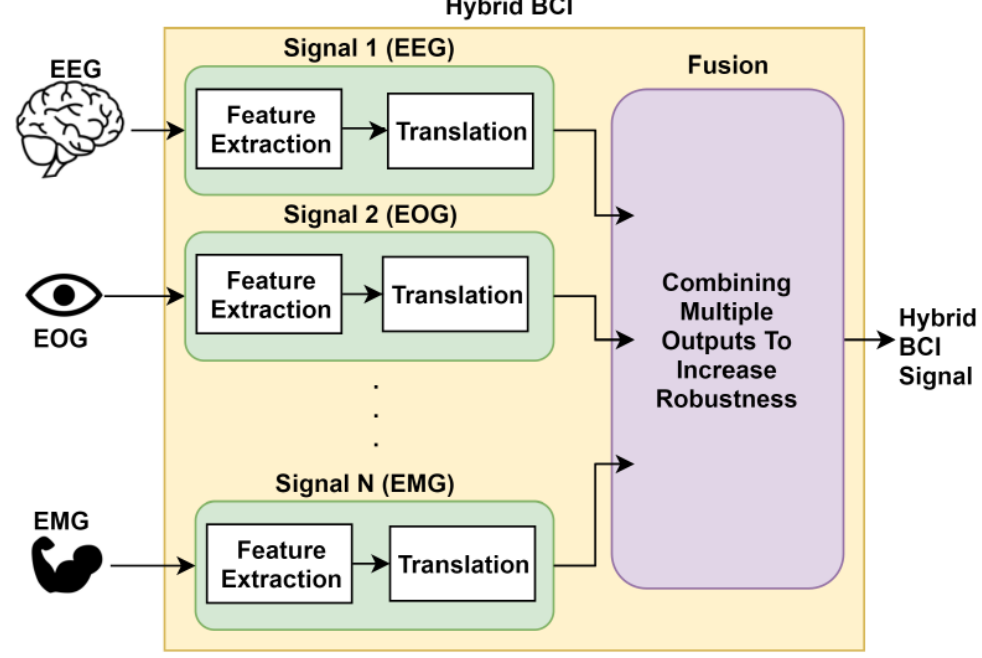
Figure 5. A hybrid brain-computer interface combined with EEG, EOG, and EMG signals